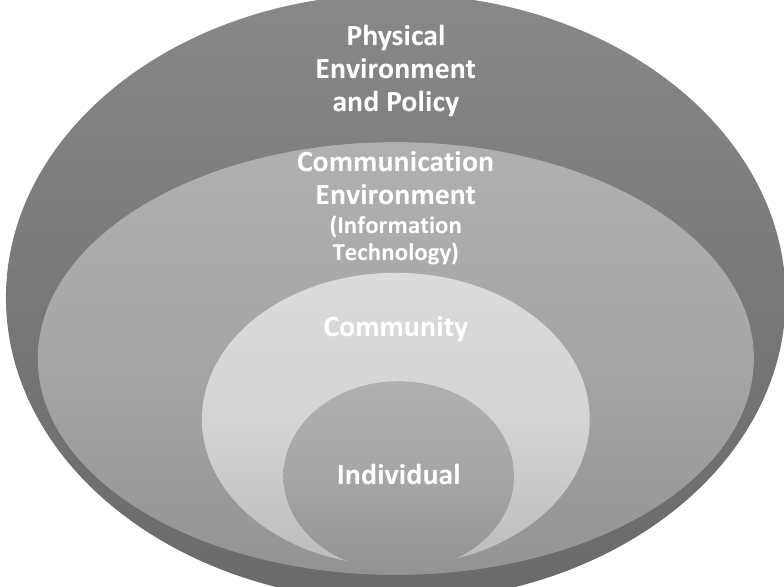
Source: Adapted from data found in Napolitano et al., 2013.